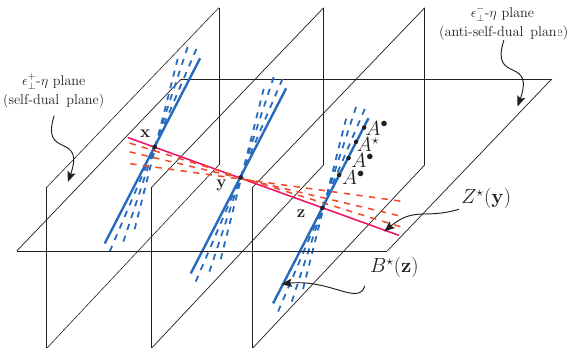
Figure 2: The geometric depiction of the Z (cid:63) field (the structure of Z • is fairly similar). Z (cid:63) field is a Wilson line (with exactly the same analytic form as B • ) of only B (cid:63) fields on anti-self-dual plane. Notice, each vertical plane is self-dual plane with B (cid:63) embedded in it as was showin in Fig. 1b. (Source of the figure: Ref. [ 8 ] .)